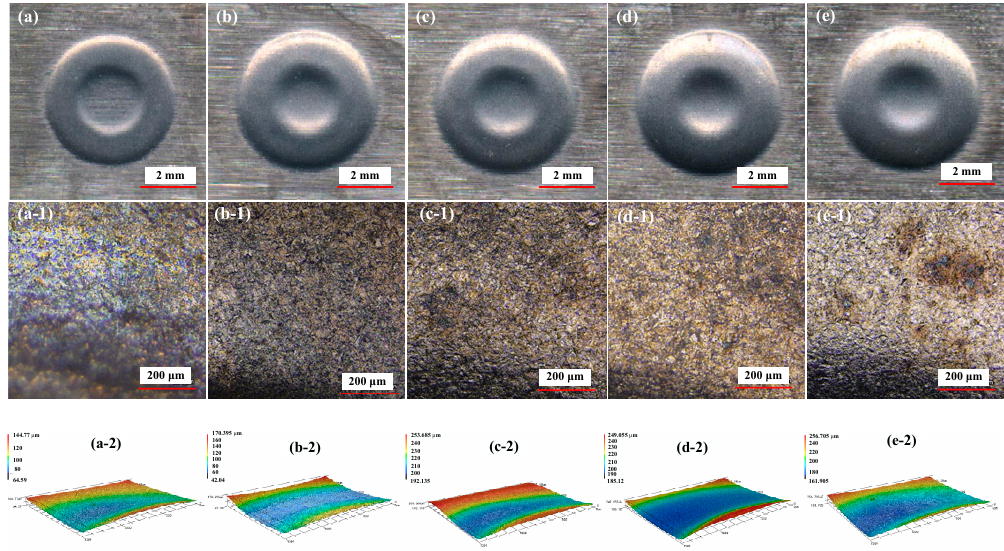
Figure 7. Surface morphology of workpiece at different current density in NaCl electrolyte: ( a ) 100 g/L, 10 A/cm 2 ; ( b ) 100 g/L, 20 A/cm 2 ; ( c ) 100 g/L, 30 A/cm 2 ; ( d ) 100 g/L, 40 A/cm 2 ; ( e ) 100 g/L, 50 A/cm 2 . Micromorphology of workpiece local surface at different current density in NaCl electrolyte: ( a-1 ) 100 g/L, 10 A/cm 2 ; ( b-1 ) 100 g/L, 20 A/cm 2 ; ( c-1 ) 100 g/L, 30 A/cm 2 ; ( d-1 ) 100 g/L, 40 A/cm 2 ; ( e-1 ) 100 g/L, 50 A/cm 2 . 3D profile of workpiece local surface at different current density in NaCl electrolyte: ( a-2 ) 100 g/L, 10 A/cm 2 ; ( b-2 ) 100 g/L, 20 A/cm 2 ; ( c-2 ) 100 g/L, 30 A/cm 2 ; ( d-2 ) 100 g/L, 40 A/cm 2 ; ( e-2 ) 100 g/L, 50 A/cm 2 .